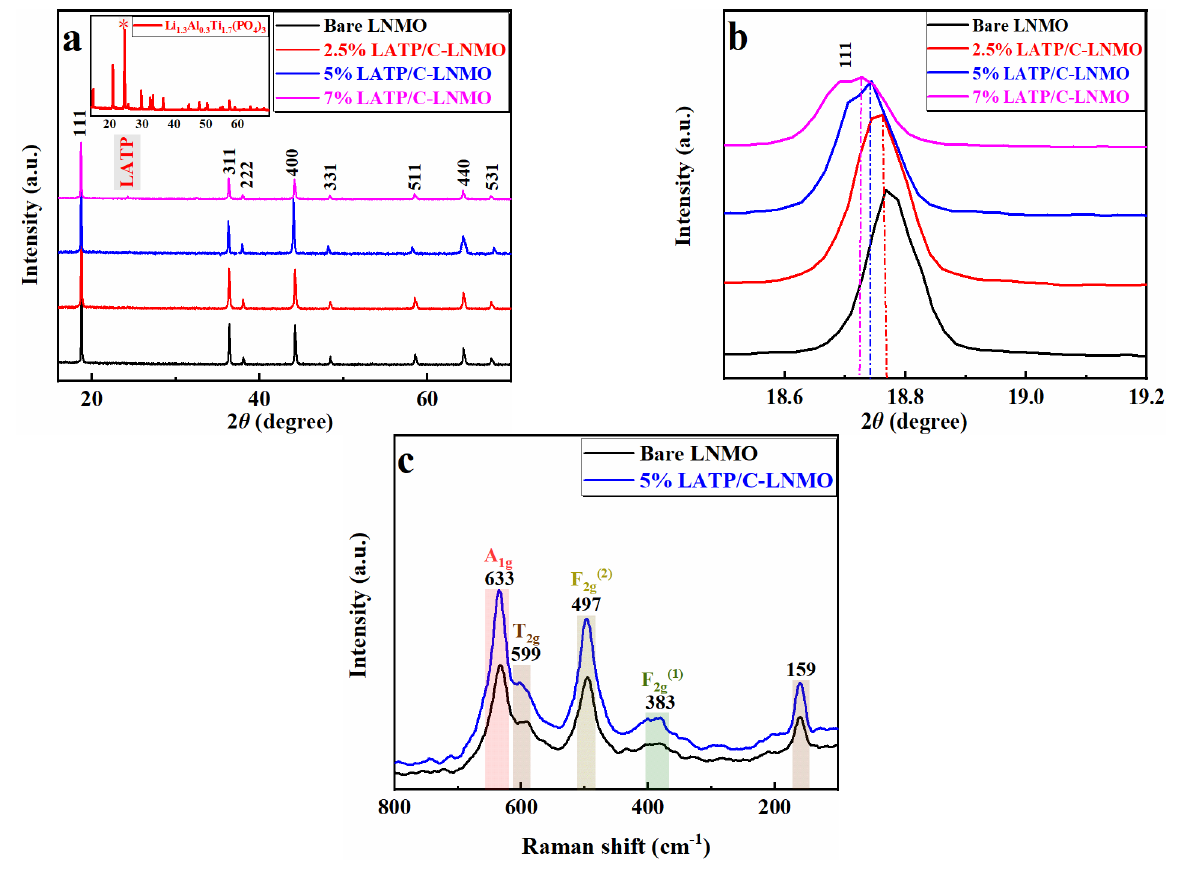
Figure 2. XRD patterns of ( a ) the bare LiNi 0.5 Mn 1.5 O 4 , LATP/C-LNMO and LATP powder and (*) the characteristic peaks. ( b ) enlarged view of the (111) diffraction peak ( c ) Raman spectra of the bare and 5% LATP-modified LNMO materials.